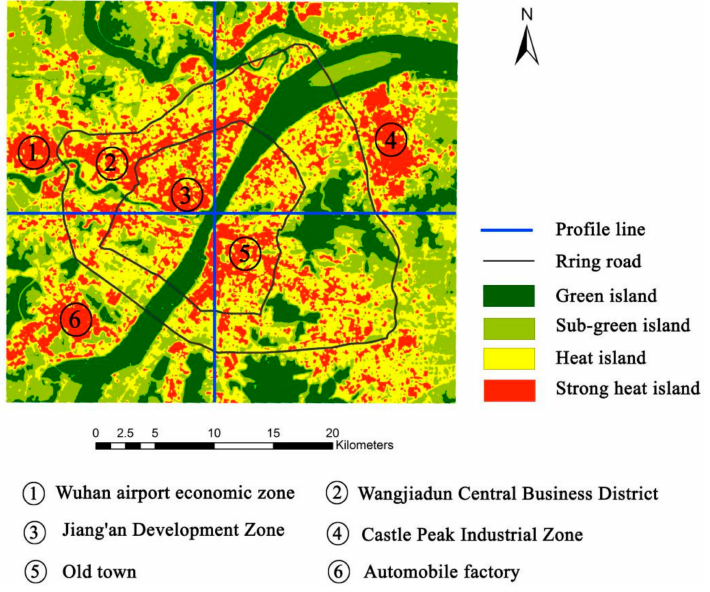
Figure 6. Urban heat island intensity level identification results in